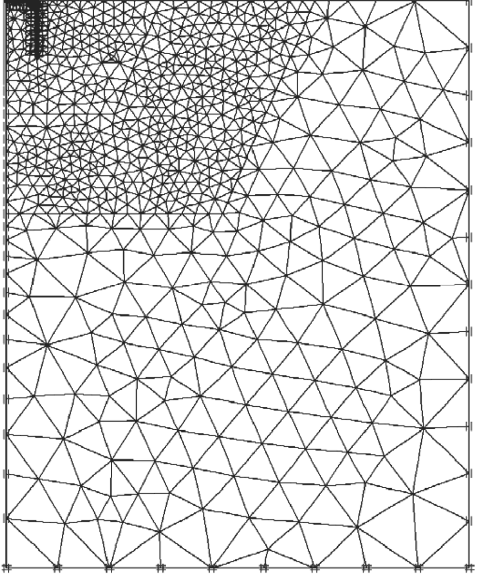
Fig. 14. Finite element mesh of bucket foundation under verti- cal